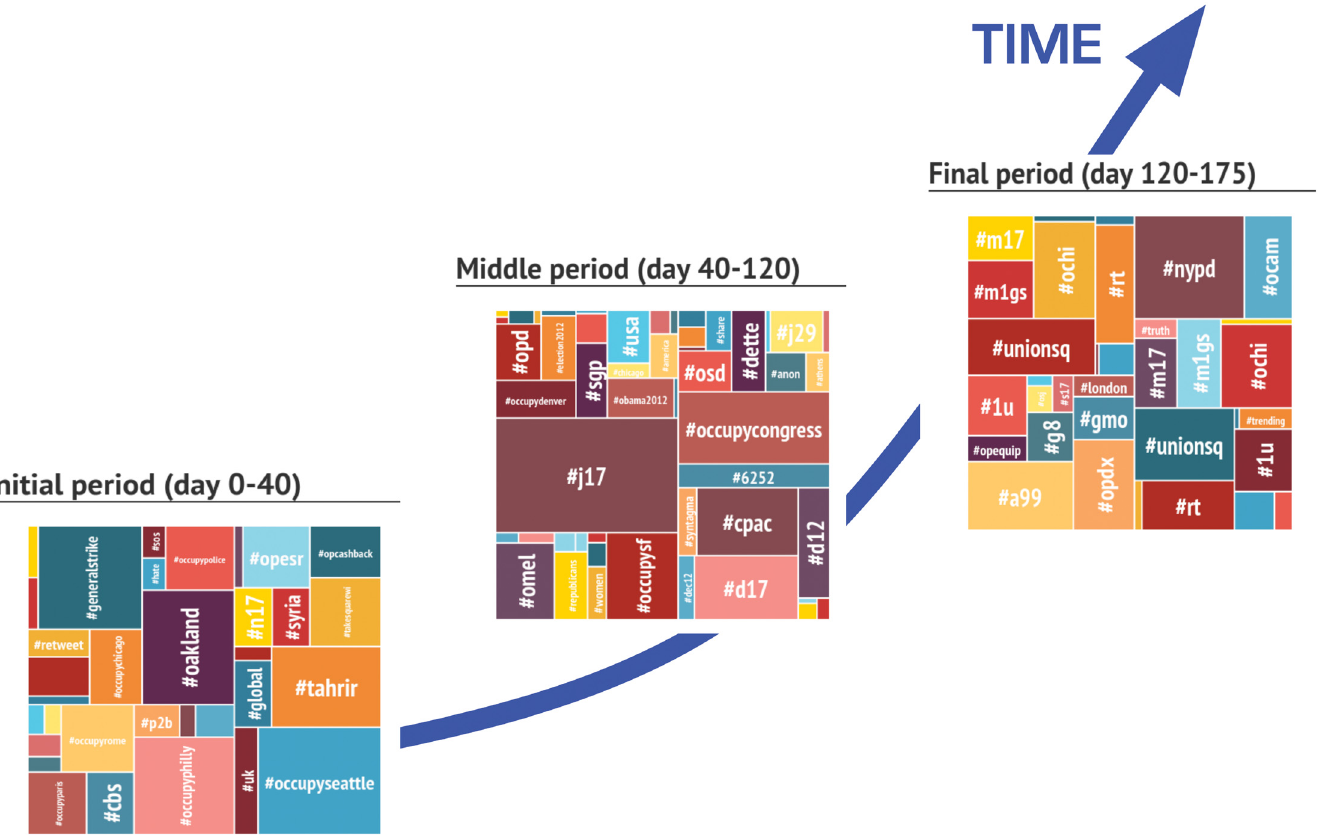
Fig 6. Top hashtags in the three phases of the Occupy Wall Street Movement. Each square corresponds to one specific period of movement and report the top most used hashtags in the period. The size of the square around each hashtag is proportional to the number of times it has been